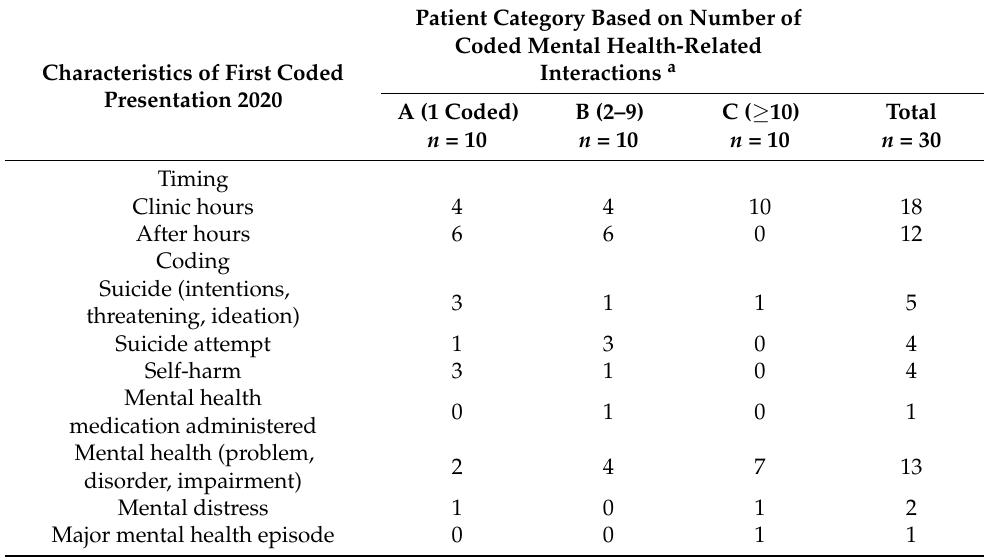
Table 4. Characteristics of first mental-health coded presentation for 30 file review